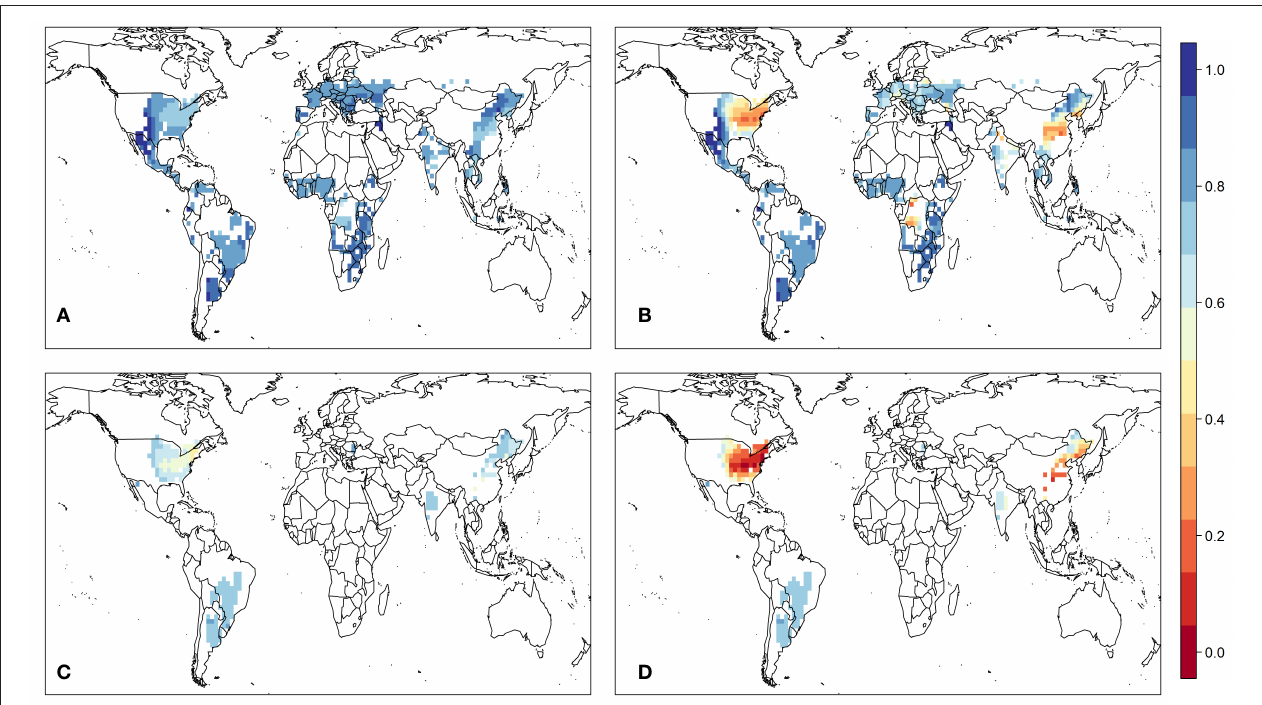
FIGURE 12 | Mean relative yield of maize under (A) low and (B) high plant-to-O 3 sensitivity, and mean relative yield of soybean under (C) low and (D) high plant-to-O 3 sensitivity, as simulated by TEMIR-crop under a present-day CO 2 concentration of 390 ppm.